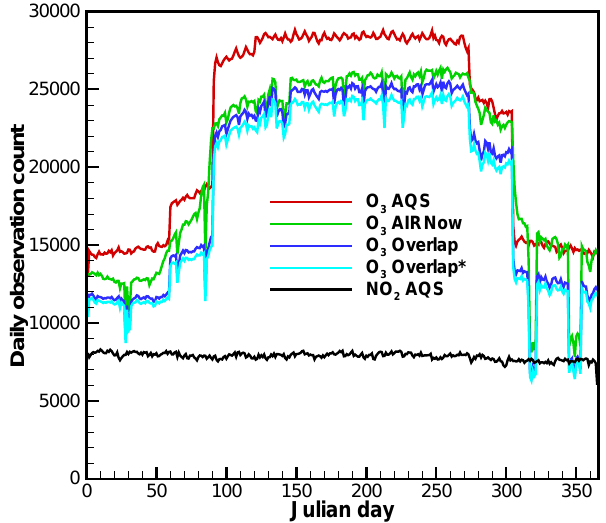
Fig. 2. Data counts of ozone and NO 2 hourly measurements for each day during 2010. “O 3 overlap” shows the number of overlap- ping ozone observation pairs and “O 3 overlap*” is the number of observation pairs after removing measurements from the 74 ques- tionable sites (see text for